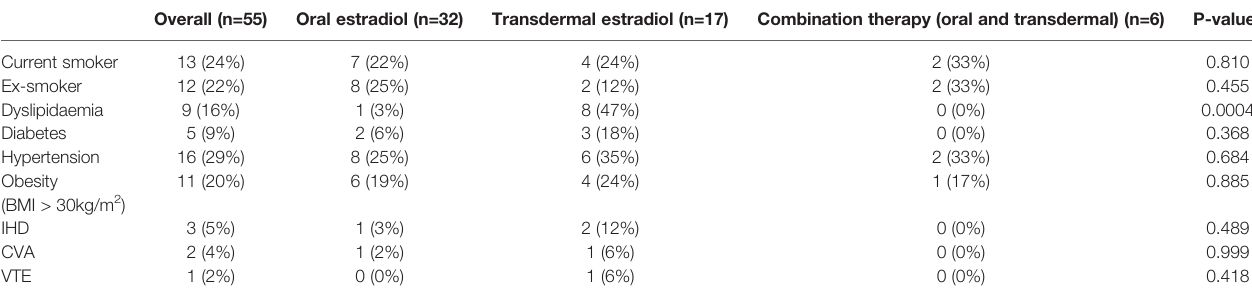
TABLE 2 | Cardiometabolic risk factors ( ≥ 45 years age group). Overall